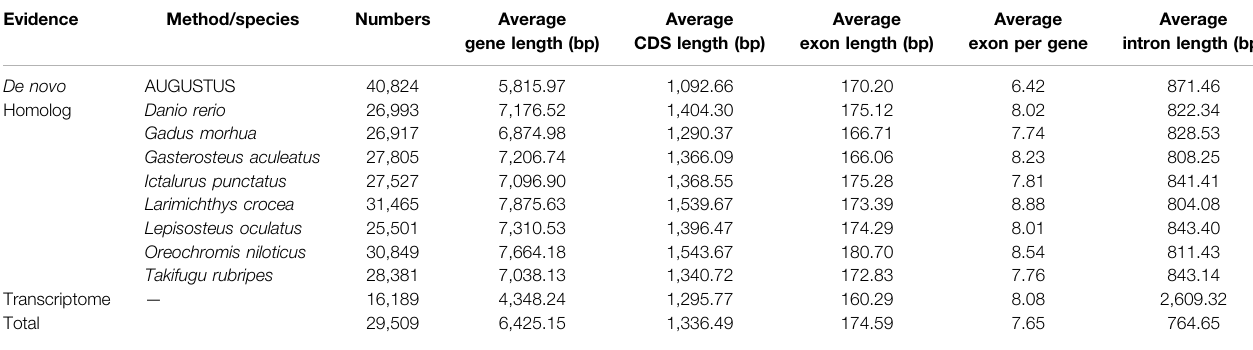
TABLE 3 | Predicted protein-coding genes in the genome of spiny head